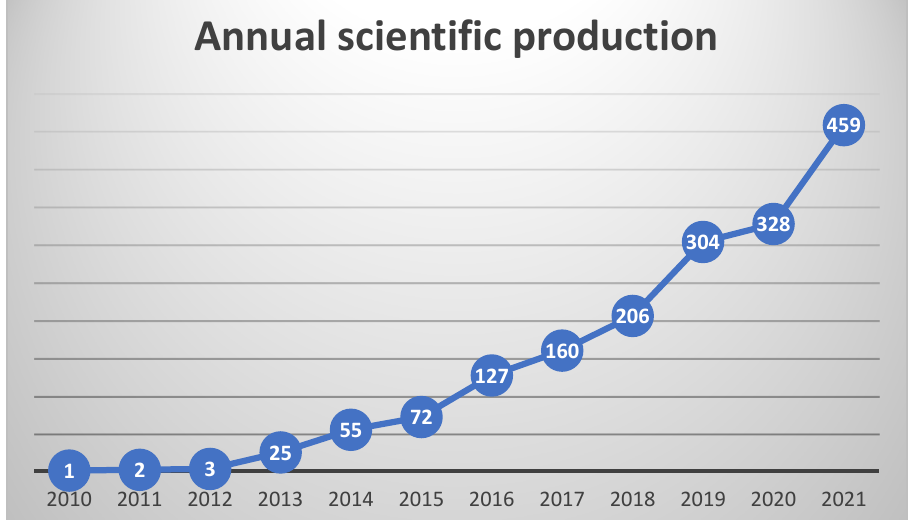
Figure 1. Annual scientific production.